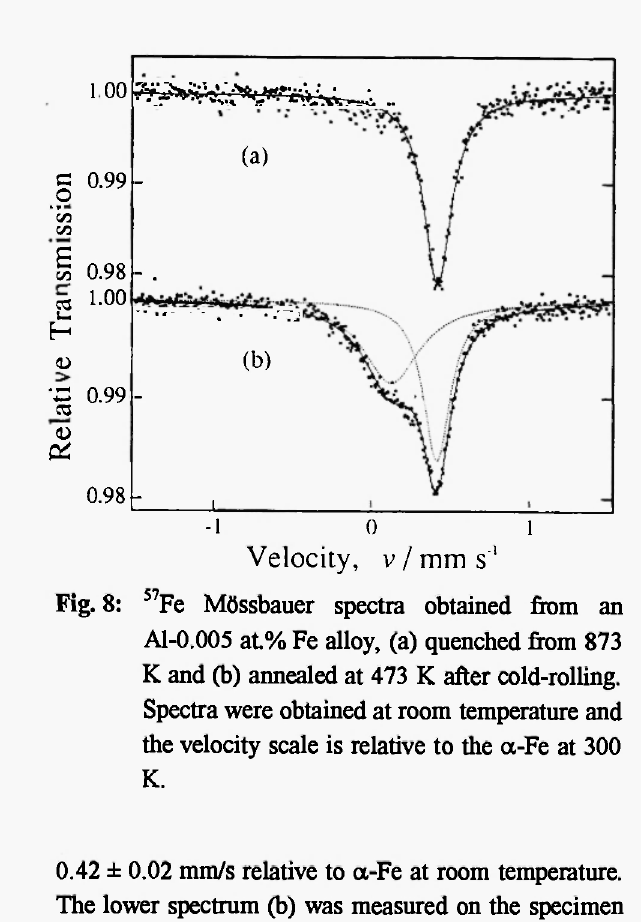
0.42 ± 0.02 mm/s relative to α-Fe at room temperature. The lower spectrum (b) was measured on the specimen spectrum (a), but aging treatment at 200°C was